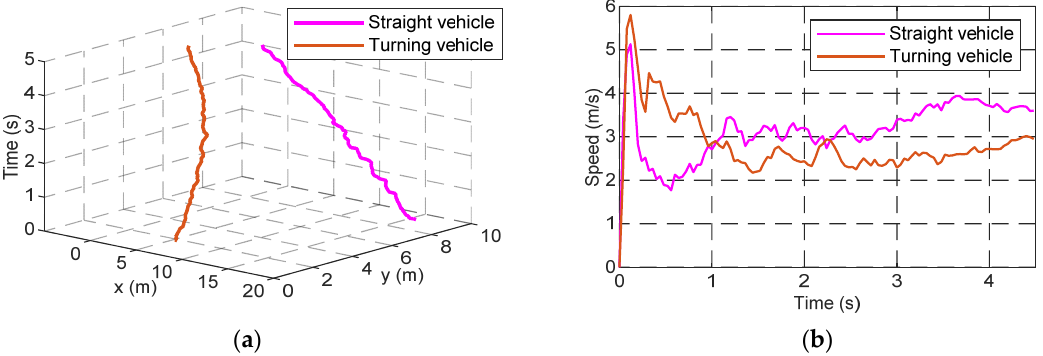
Figure 7. One example of Open ITS: ( a ) position of straight and turning vehicles, ( b ) acceleration of straight and turning vehicles.